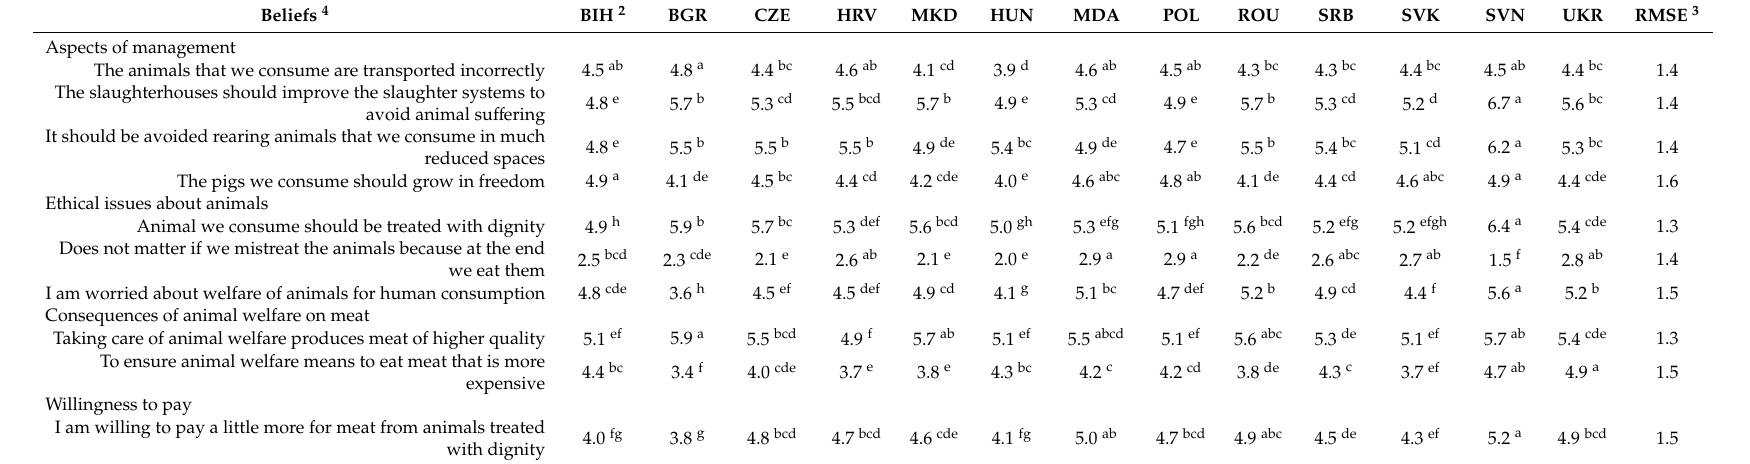
Table 3. The beliefs of Eastern European consumers about animal welfare and the e ff ect of the country 1 . Beliefs 4 BIH 2 BGR CZE HRV MKD HUN MDA POL ROU SRB SVK SVN UKR RMSE